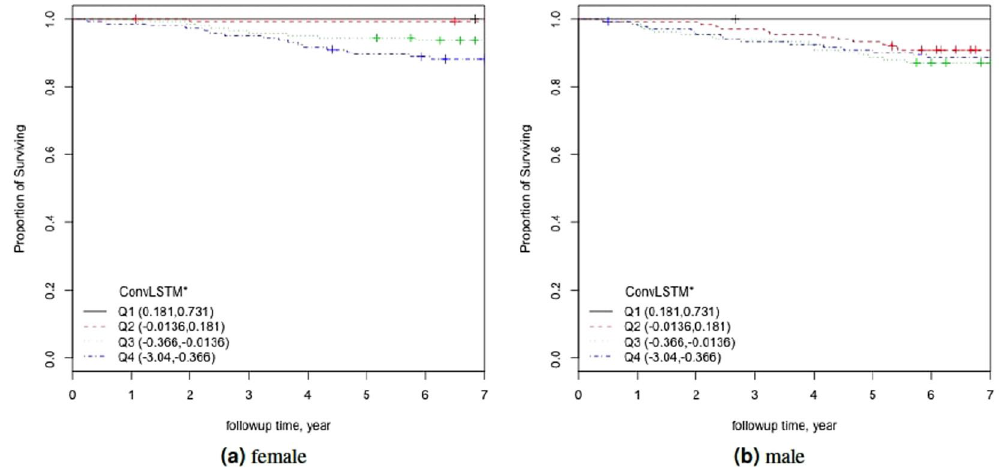
on the physical activity ( a ) female, and ( b ) male. CA